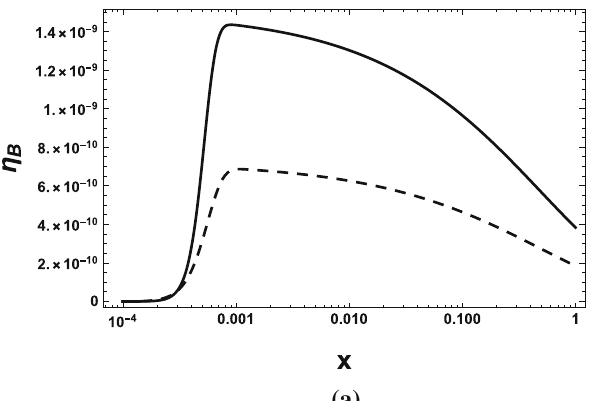
= 45 × 10 − 5 . The solid line 0